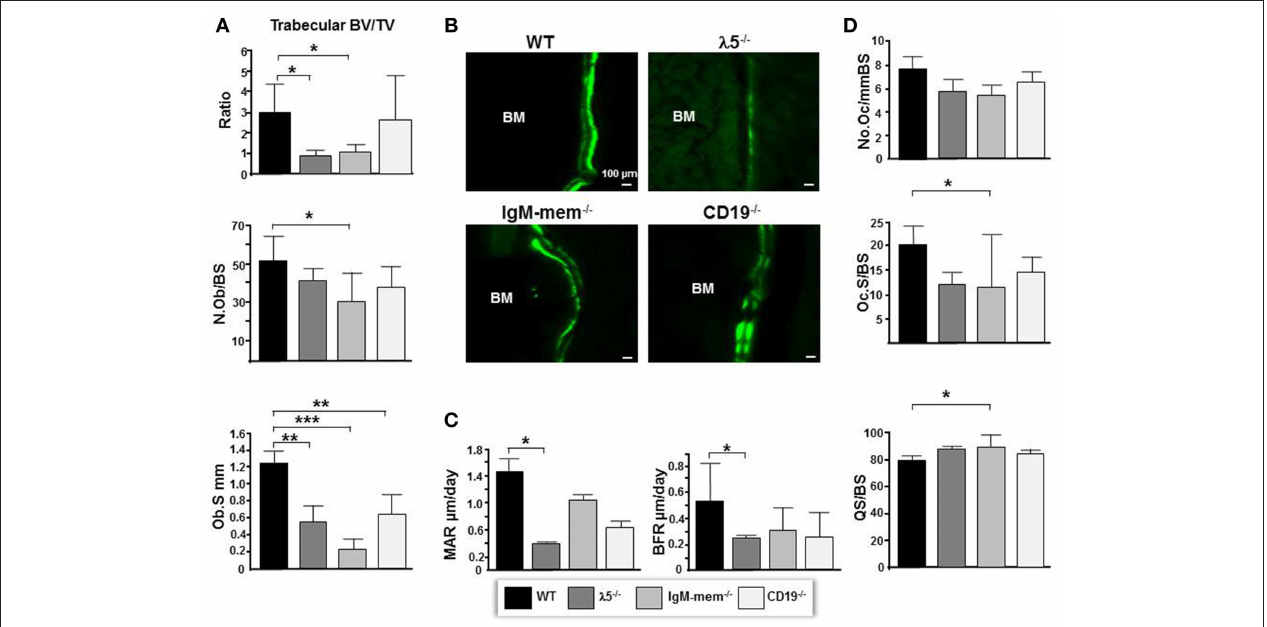
FIGURE 2 | Deficiencies in preBCR formation and function result in decreased osteoblast numbers and bone synthesis. (A) Average histomorphometric values pooled from n = 3 animals are presented in the graph. Bone parameters shown are trabecular BV/TV ratio, the average number of osteoblasts per bone surface (N.ob/BS), and the average osteoblast surface (Ob.S) for the indicated genotype. (B) Undecalcified hindlimbs were embedded in plastic and sectioned laterally. Representative phase and FITC fluorescent images taken at the same exposure time show areas of double labeled bone surfaces in WT and mutant femurs. (C) Dynamic histomorphometry was performed on calcein labeled bones. Shown are the average mineralizing parameters for the mineral apposition rate (MAR) and bone formation rate (BFR). (D) Frontal sections of femurs were stained for TRAP activity. Shown are the average number of osteoclasts per bone surface (N.Oc/BS), the average osteoclast surface per bone surface (Oc.S/BS), and the quiescent surface to bone surface (QS/BS). * p < 0.05, ** p < 0.01,*** p < 0.001. Only comparisons achieving statistical significance in comparison to WT are shown.